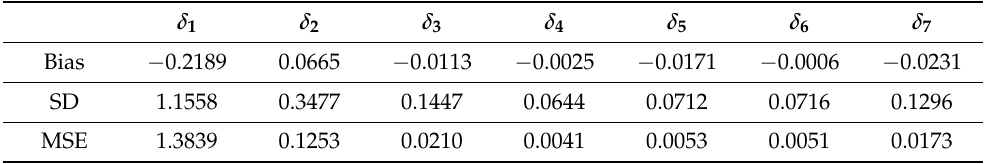
Table 6. Bias, SD and MSE evolutions with respect to the parameter δ variation for PLGSIMF with the identity link function and n = 1000.